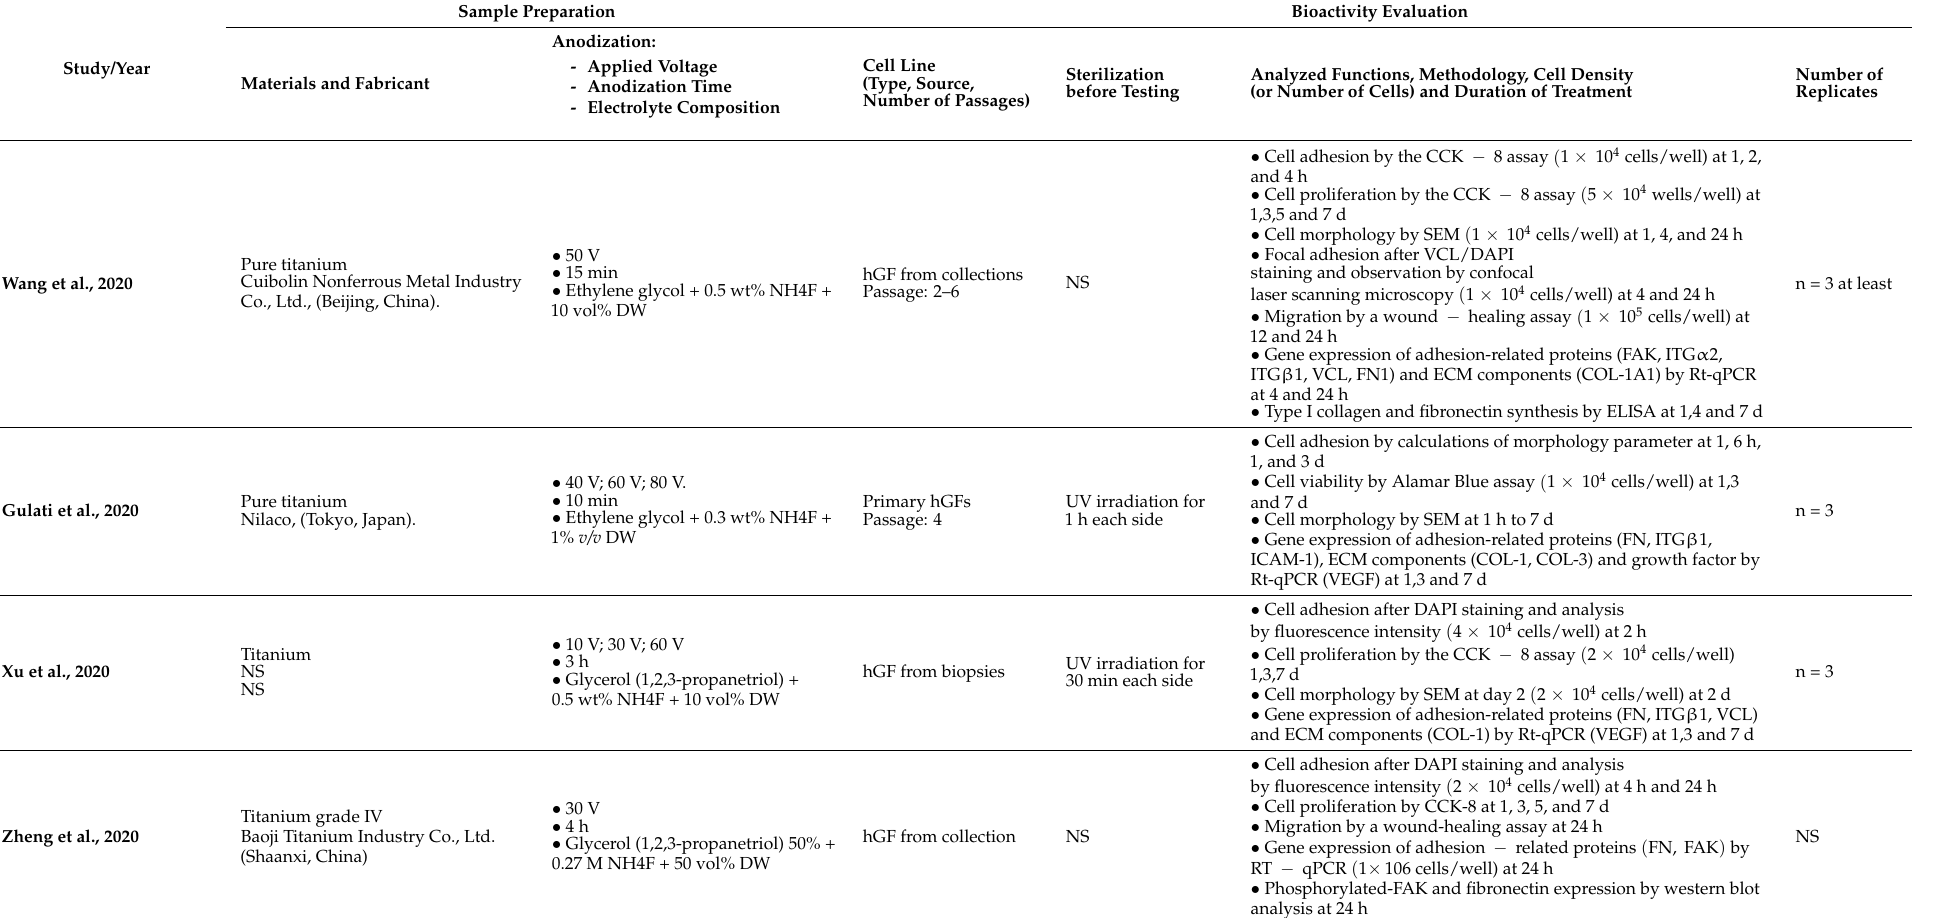
Table 3. Main characteristics of the studies